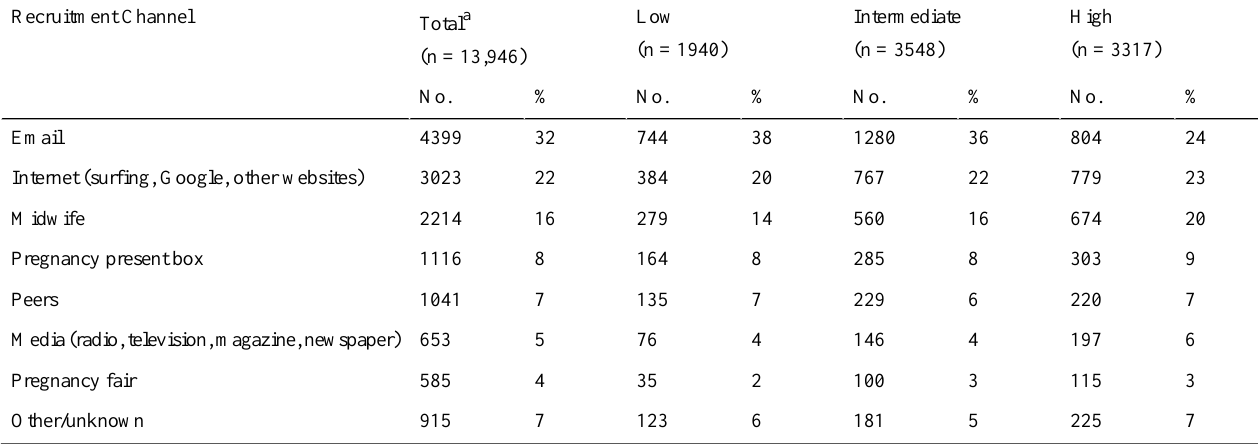
Table 2. Recruitment channel by education